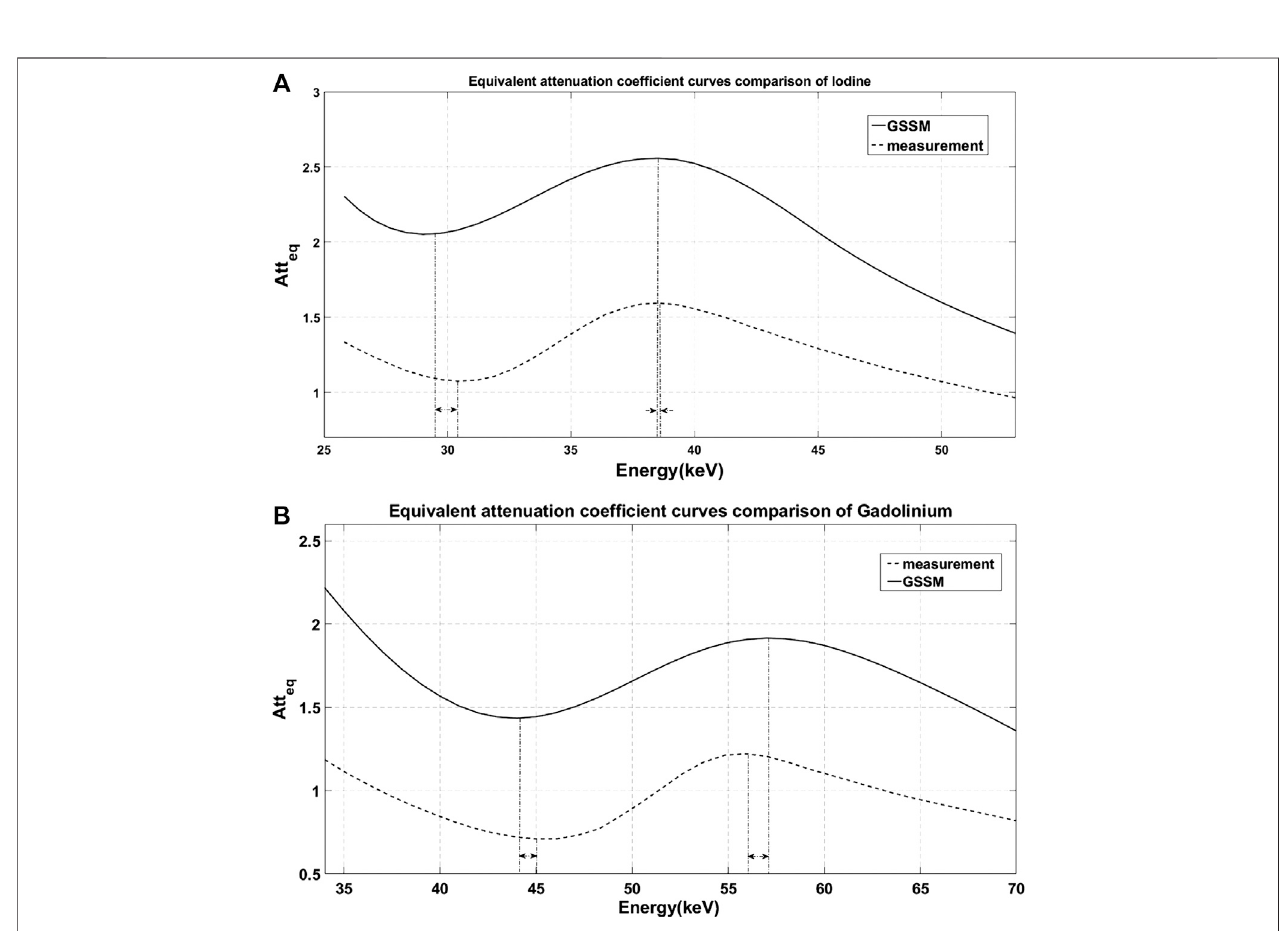
FIGURE 6 | Comparison of the equivalent attenuation coef fi cient curves obtained by GSSM (solid line) and measurement (dashed line). The dash-dotted lines represent the energy positions of the extreme points and the arrows show the errors between GSSM and measurement: (A) iodine results and (B) gadolinium results.